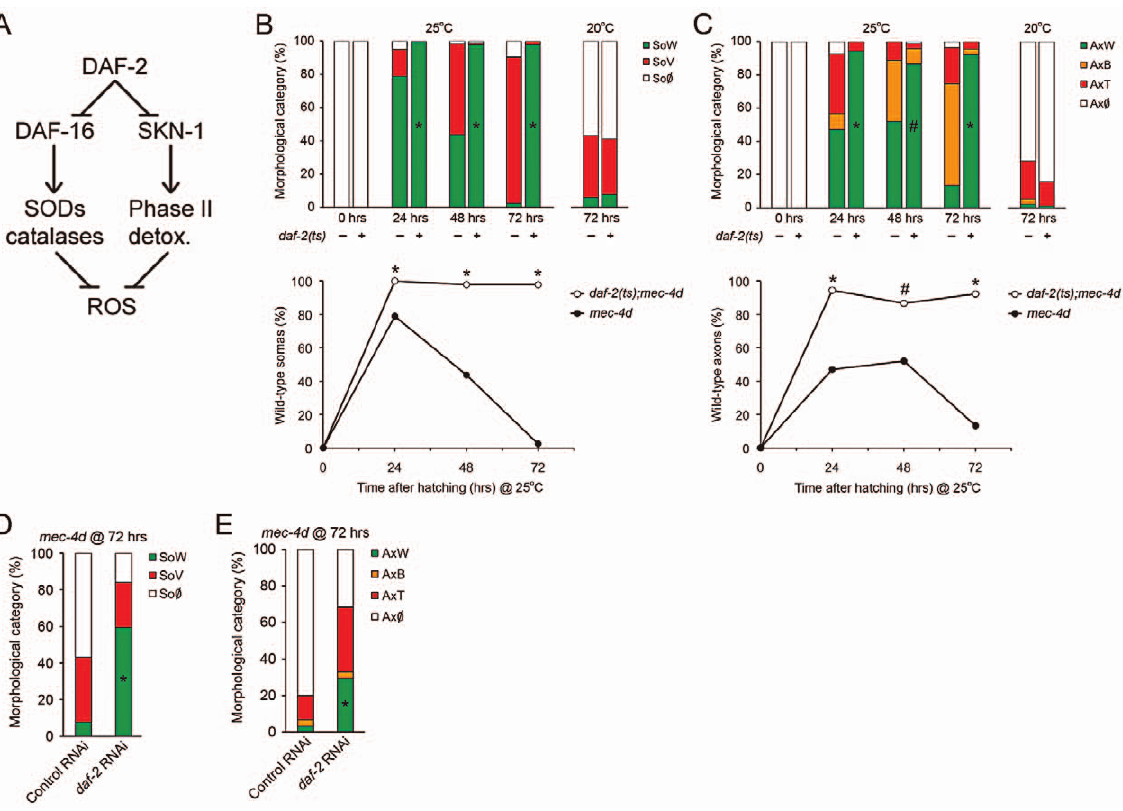
Figure 4. Downregulation of Insulin/IGF-1-like signaling (IIS) prevents neuronal degeneration triggered by mec-4d . (A) DAF-2 negatively regulates both DAF-16/FOXO and SKN-1/Nrf2, which by different mechanisms increases the cellular antioxidative capacity. (B–C) The possible protective role of the IIS pathway activation in mec-4d degeneration was explored in daf-2(e1370ts) mutants. At the restrictive temperature both somas (B) and axons (C) were significantly protected respect to the controls not carrying the mec-4d(e1611) mutation or daf-2(e1370ts) mutants carrying mec-4d(e1611) and raised at 20 u C. Below each bar graph, a line graph incorporating only the SoW and AxW of daf-2;mec-4d vs. mec-4d raised at 25 u C is shown. Notice that mec-4d -dependent degeneration of both somas and axons is delayed for about one day at 25 u C compared to 20 u C (mean value for each category is shown; error bars [ , 0.1%] are not included; N=3 of 30 worms each per group; # p , 0.05 and *p , 0.01 by Student’s t test compared with control at the same temperature for the SoW and AxW category). (D–E) TRN-autonomous daf-2(RNAi) was performed in the P